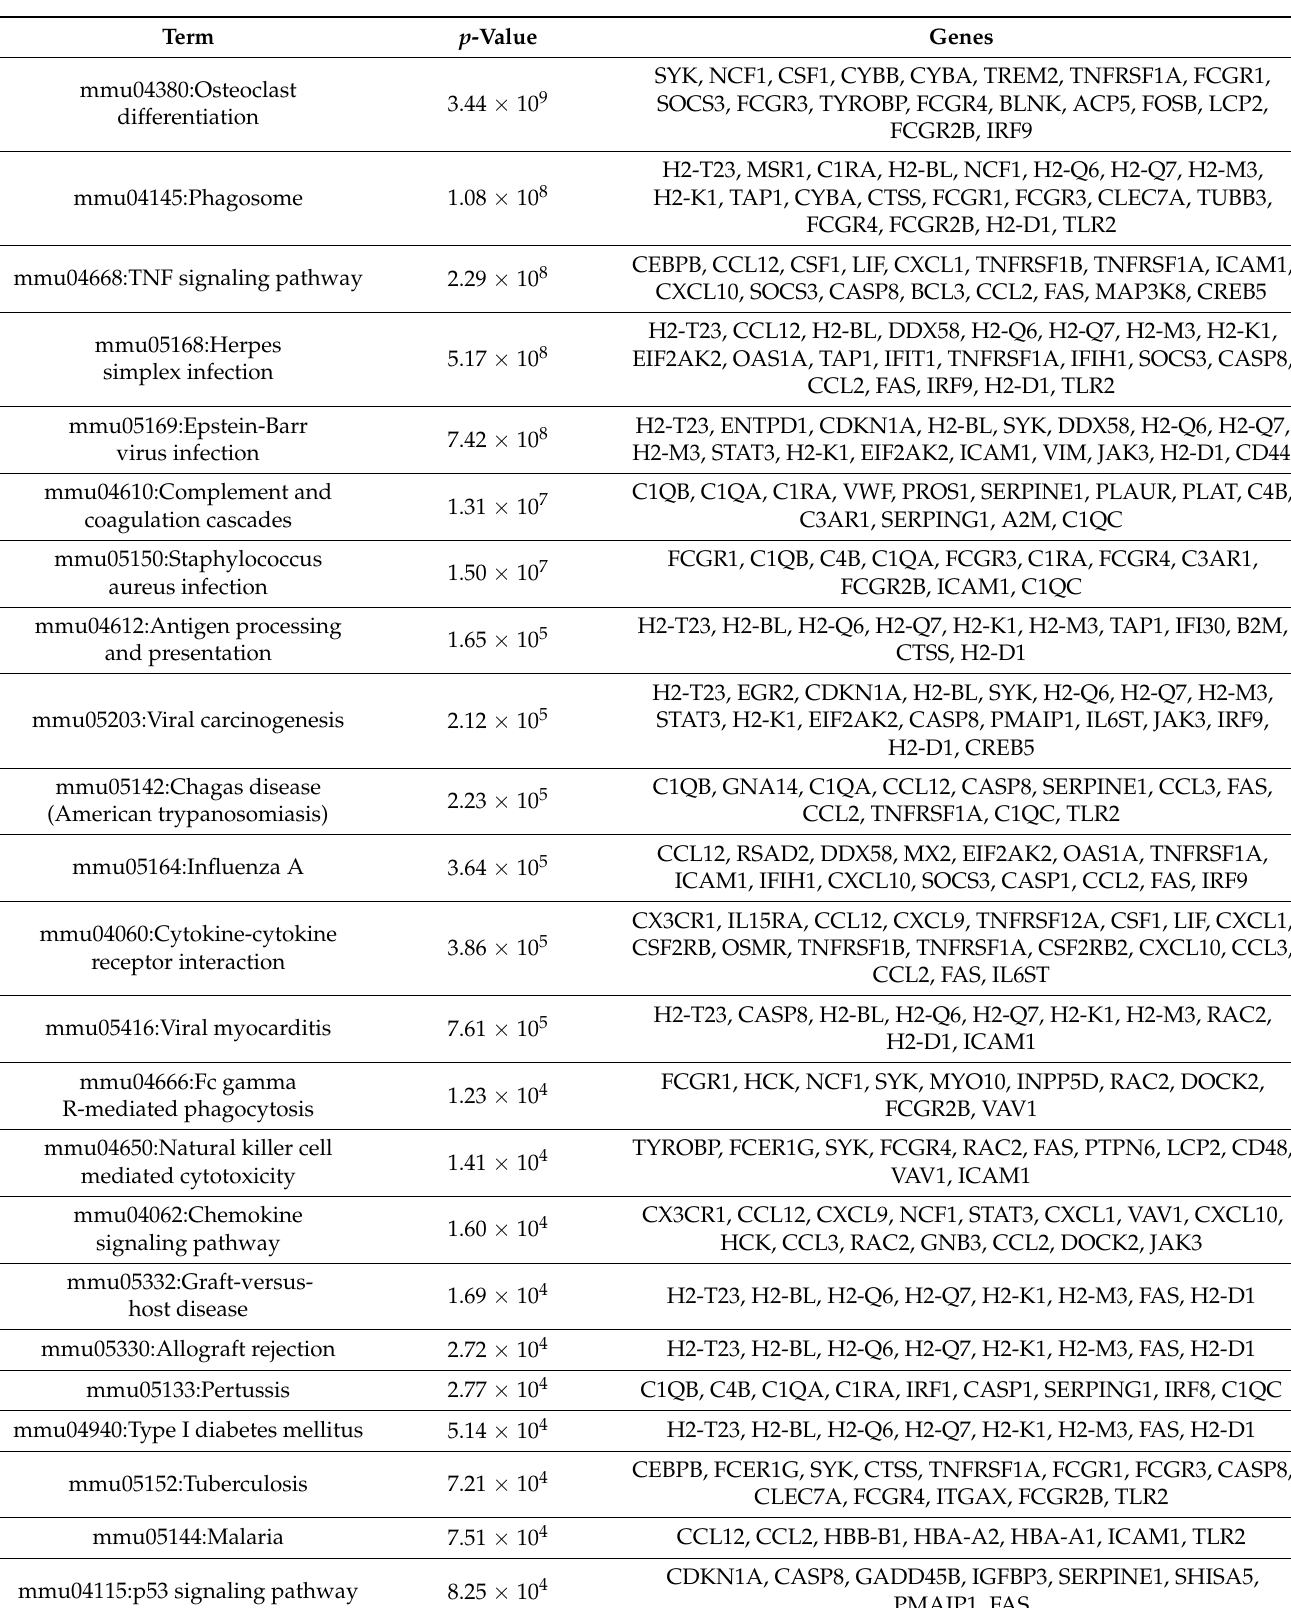
Table 3. KEGG pathway enrichment